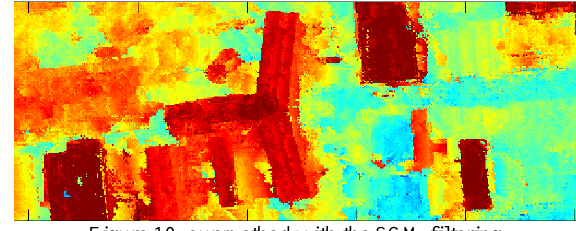
Figure 10. our method with the SGM filtering